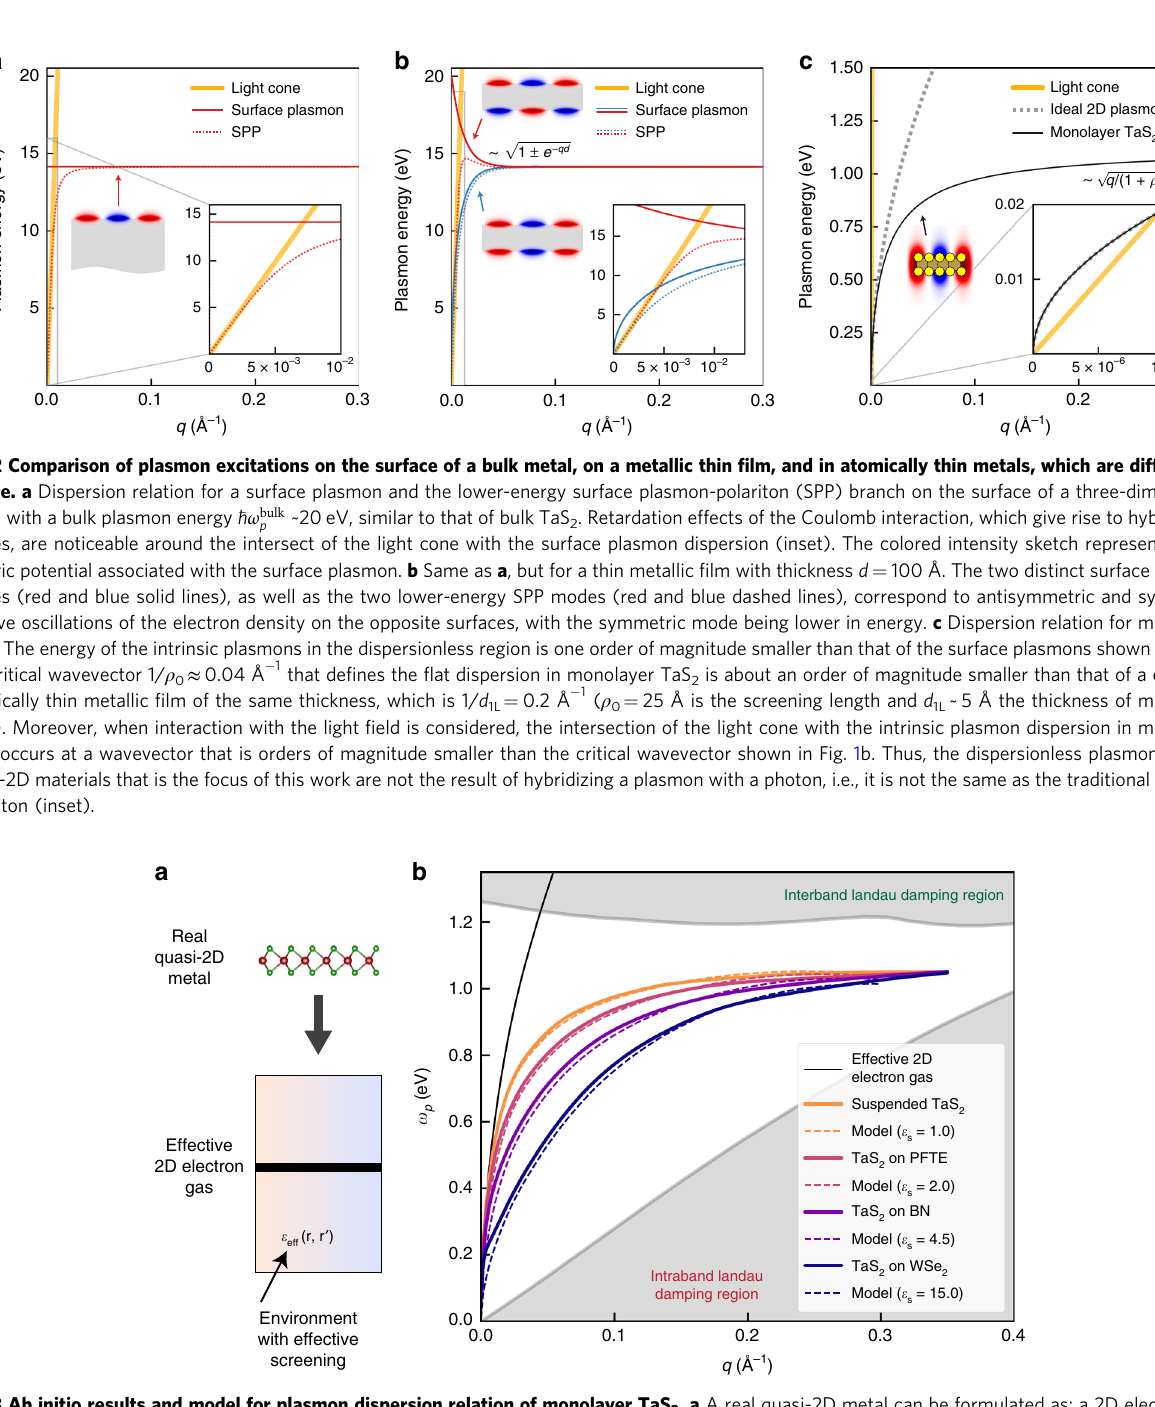
Fig. 3 Ab initio results and model for plasmon dispersion relation of monolayer TaS 2 . a A real quasi-2D metal can be formulated as: a 2D electron gas with renormalized properties given by the energy band (or bands) that crosses the Fermi energy (thick band in Fig. 1a) embedded in an environment with an effective screening, which accounts for the interband transitions and environmental effects (Eq. (1) and Fig. 1c). b Calculated plasmon dispersion relation of monolayer TaS 2 on a variety of substrates (Polytetra fl uoroethylene (PTFE), BN, WSe 2 ) – calculated from fi rst principles (solid colored lines) and computed with the expression given in Eq. (1) (dash colored lines). For the latter, we fi t the ab initio computed intrinsic effective dielectric screening ε eff ( q ) of suspended TaS 2 to the form of a Keldysh model 21 . The resulting curves of the model on different substrates are then obtained without any additional fi tting. The Landau damping regions are also shown (gray shaded regions), which is associated with the electron-hole continuum of either intraband or interband transitions (Fig.